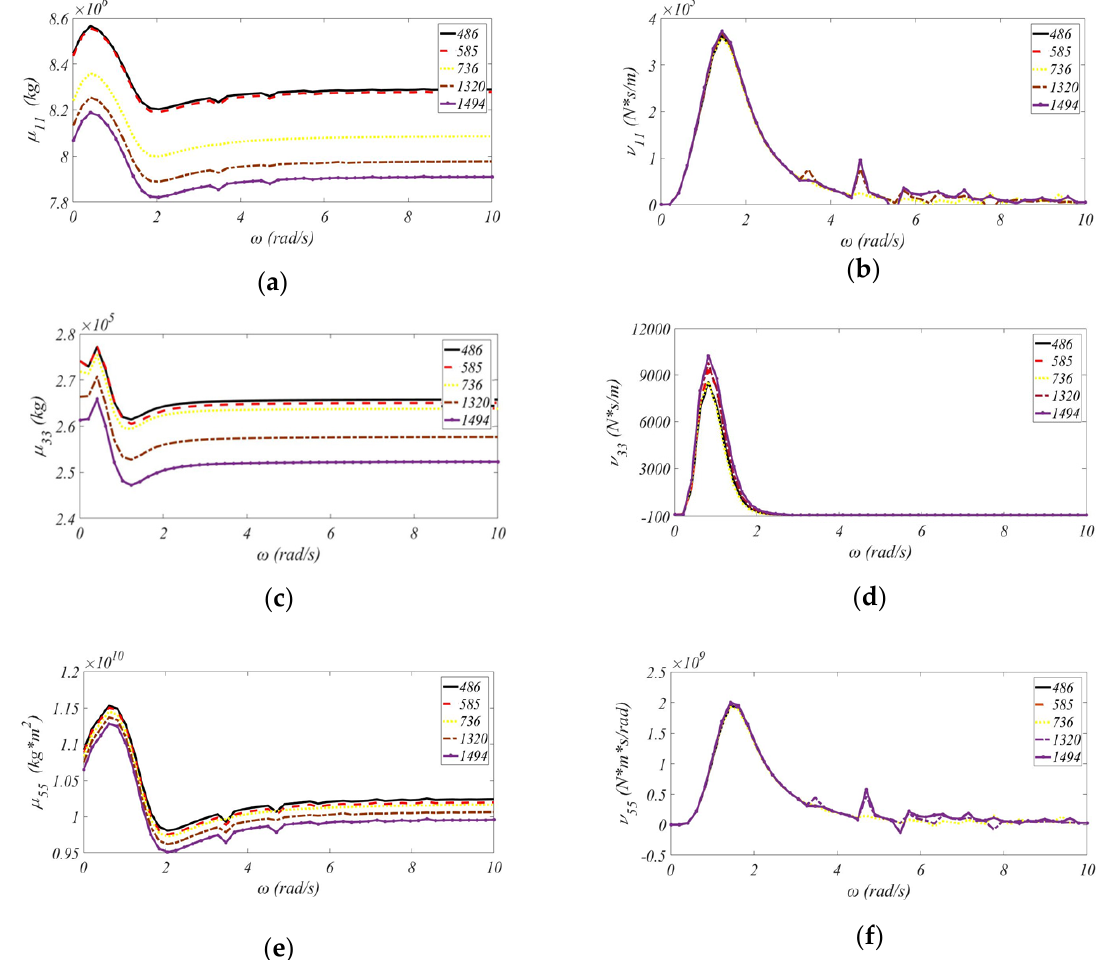
Figure 9. The mesh convergences for hydrodynamic coefficients ( a ) µ 11; ( b ) ν 11; ( c ) µ 33; ( d ) ν 33; ( e ) µ 55; and ( f ) ν 55 of wetted hull for the OC3-Hywind spar under different panel numbers. In addition, the aspect ratios of triangular panels for upper column, taper and base column of the spar buoy are set to 1.63/0.33 for 642 panels, 0.86/0.5 for 236, and 1.72/1 for 442 panels, respectively. Eventually, all panels can be grouped into three families of the same size and proportion by panel